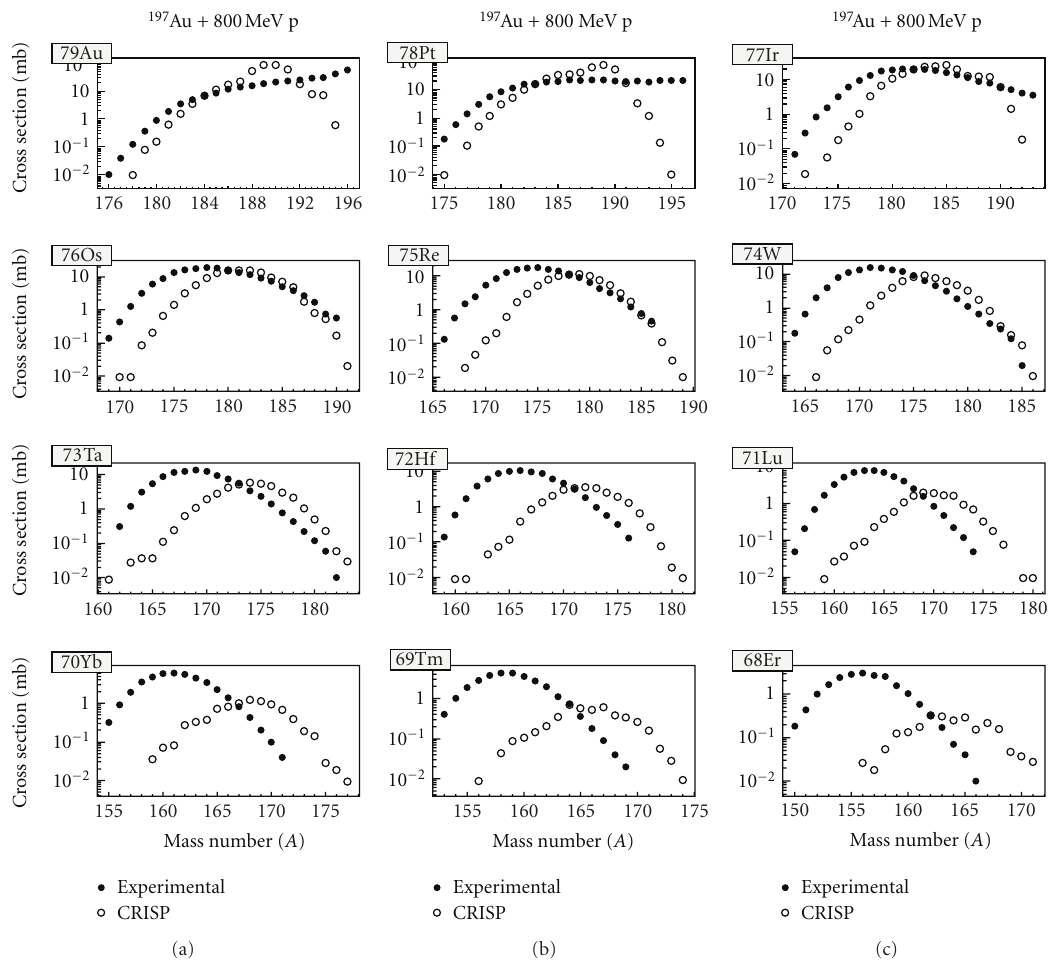
Figure 5: Cross section for fragments produced in spallation of 197 Au induced by 800 MeV